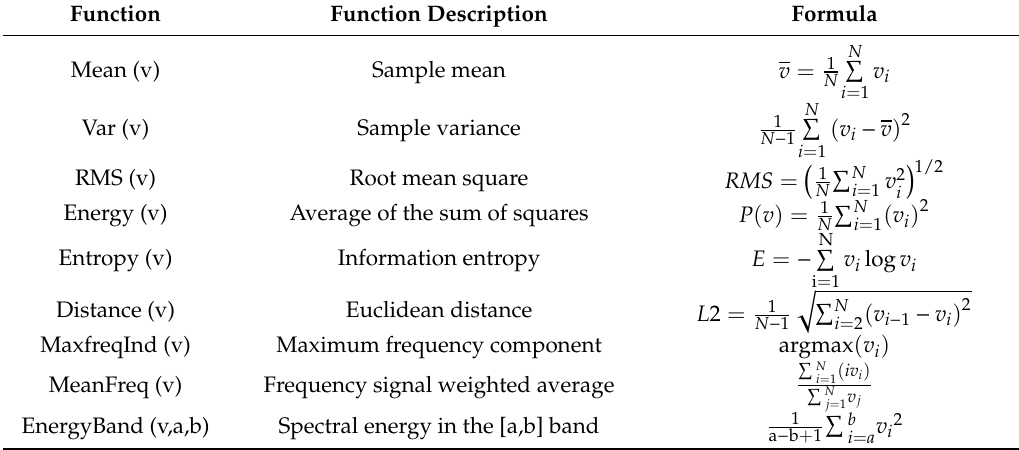
Table 3. Feature Vector.